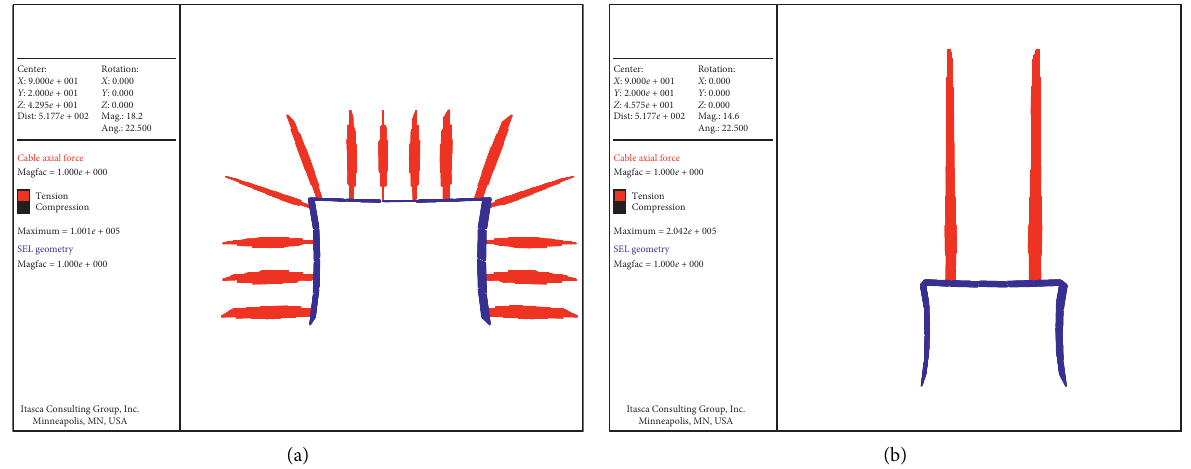
Figure 20: The force diagram of bolt and anchor is shown. (a) Bolt; (b)